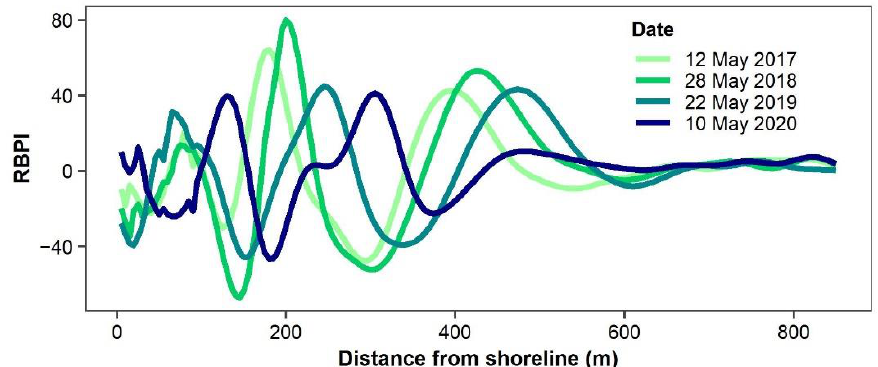
Figure 3. An example time series of filtered profiles of Relative Bathymetric Position Index (RBPI). The NOM pattern is clearly detectable in the time series.